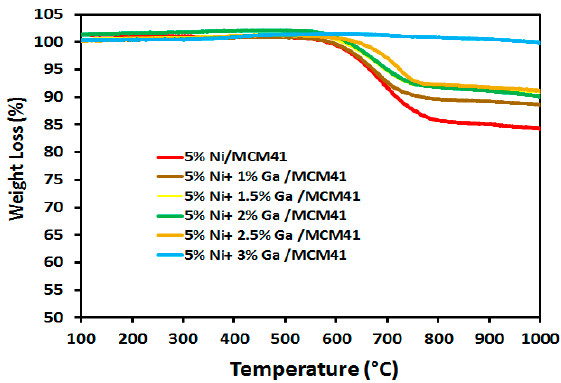
Figure 5. TGA curves for the used catalysts under atmospheric pressure with a heating rate of 20 °C/min.